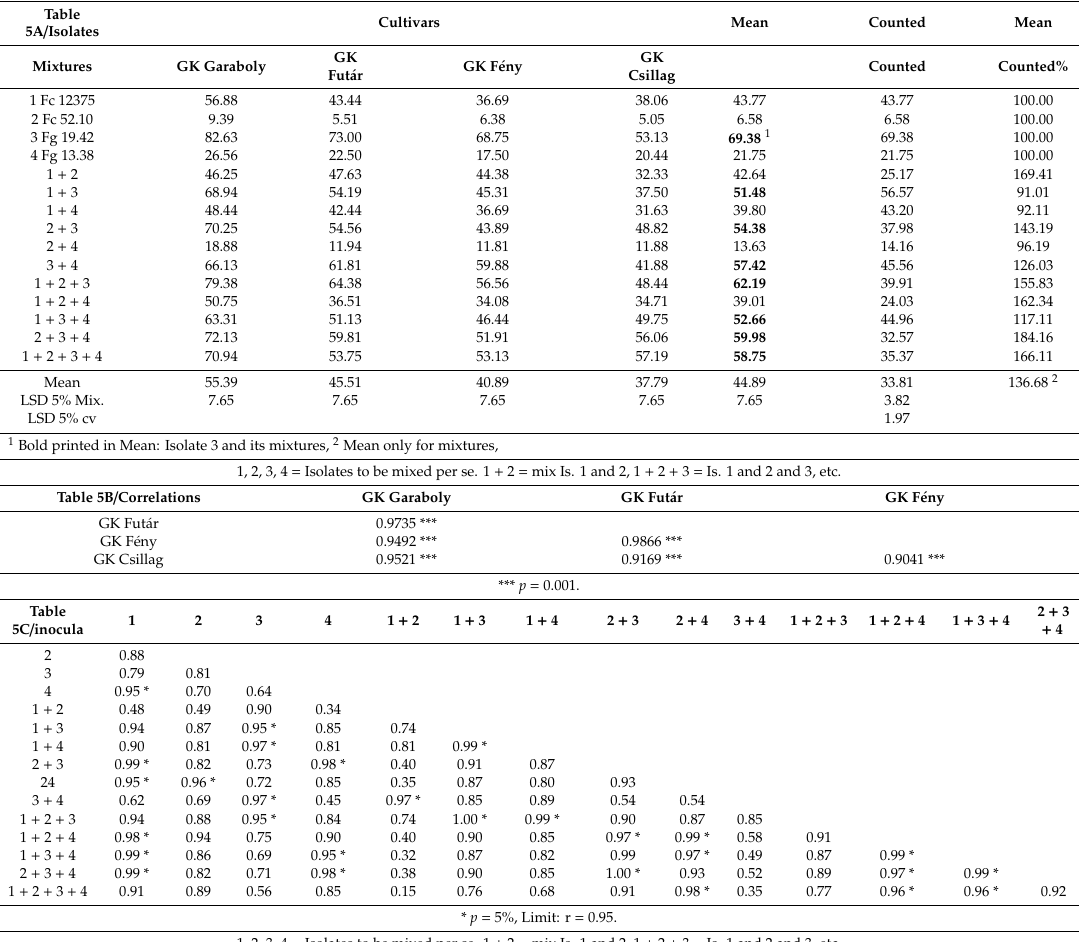
Table 5. Response of the wheat cultivars to the di ff erent isolates and their mixtures. FDK data (%) across experiments, Szeged, 2013–2015. Table 5A / Isolates Cultivars Mean Counted Mixtures